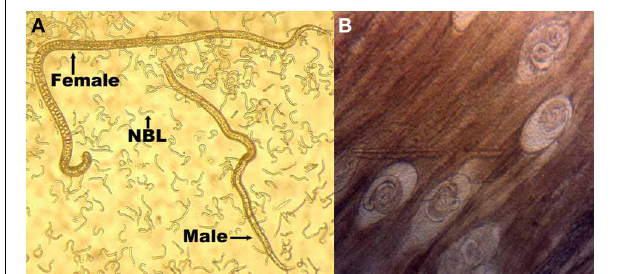
FIGURE 1 | Three main life-stage forms of T. spiralis . (A) Adults and new born larvae (NBL) and (B) infective muscle larvae. Female adults, which develop in the small intestine, will produce new-born larvae, which then disseminate through the bloodstream, invade skeletal muscles, and encyst in a collagen capsule to form a new generation of muscle